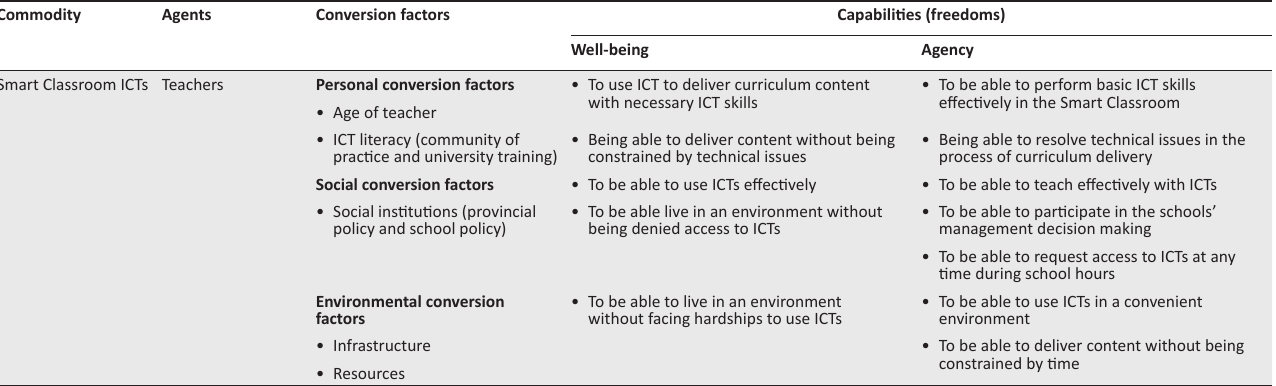
TABLE 2: Conversion factors and